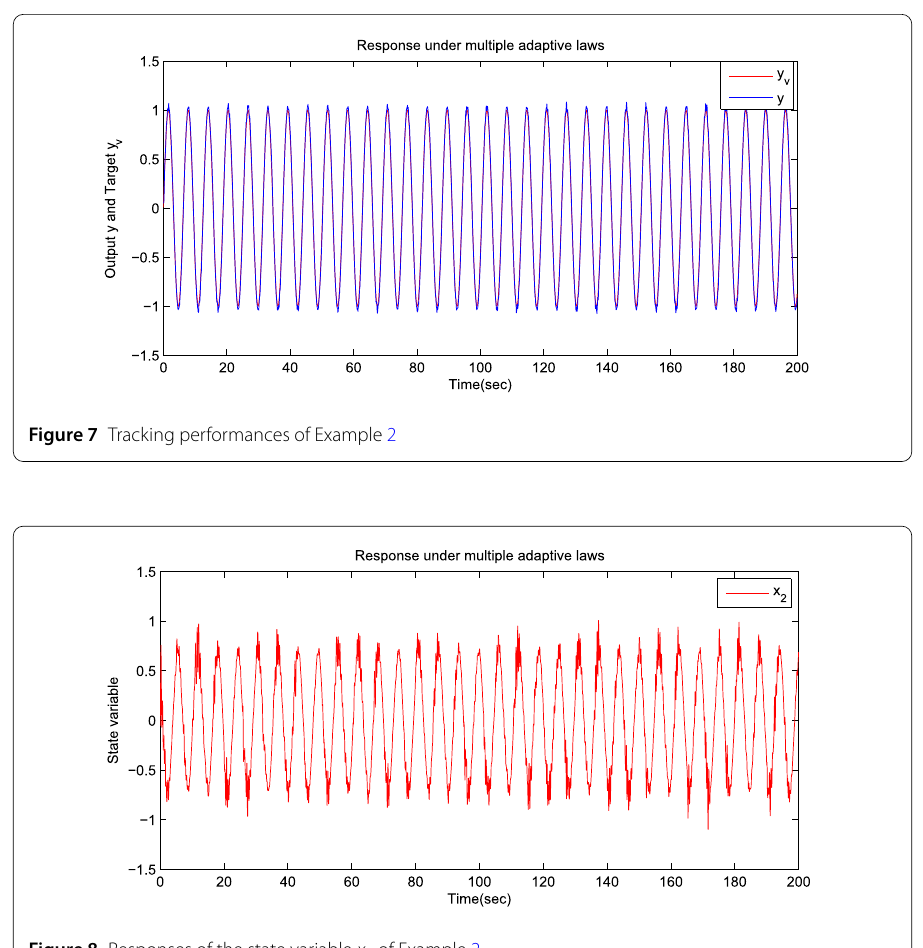
Figure 8 Responses of the state variable x 2 of Example 2